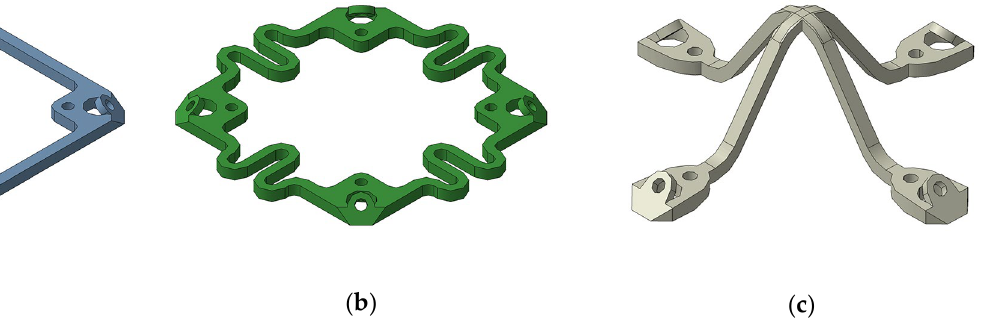
Figure 17. Component-level facet elements: ( a ) Facet element of the rigid cell; ( b ) Facet element of the compliant cell; ( c ) Facet element of the auxetic cell.